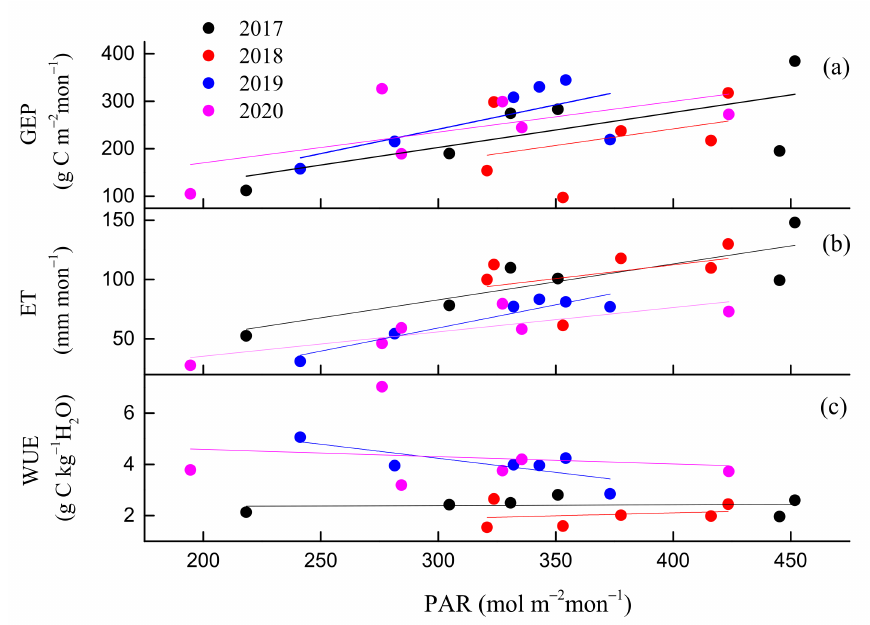
Figure 10. Responses of monthly ( a ) gross ecosystem productivity (GEP), ( b ) evapotranspiration (ET) and ( c ) water use efficiency (WUE) to PAR during the growing seasons from 2017 to